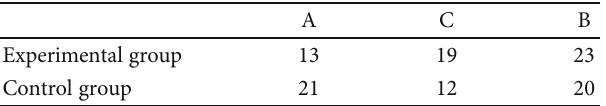
Table 5: The tympanic negative pressure of both ears before treatment.